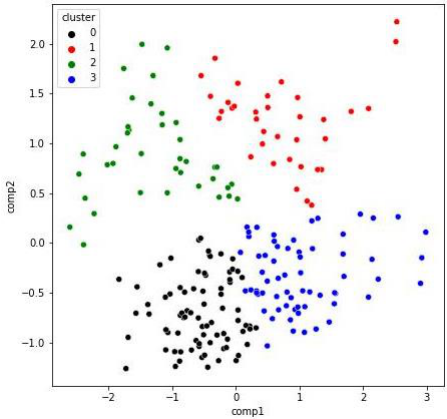
Figure 5. k –means clustering for observations (houses) obtained with FAMD. We used k = 4 clusters considering 3 PC as